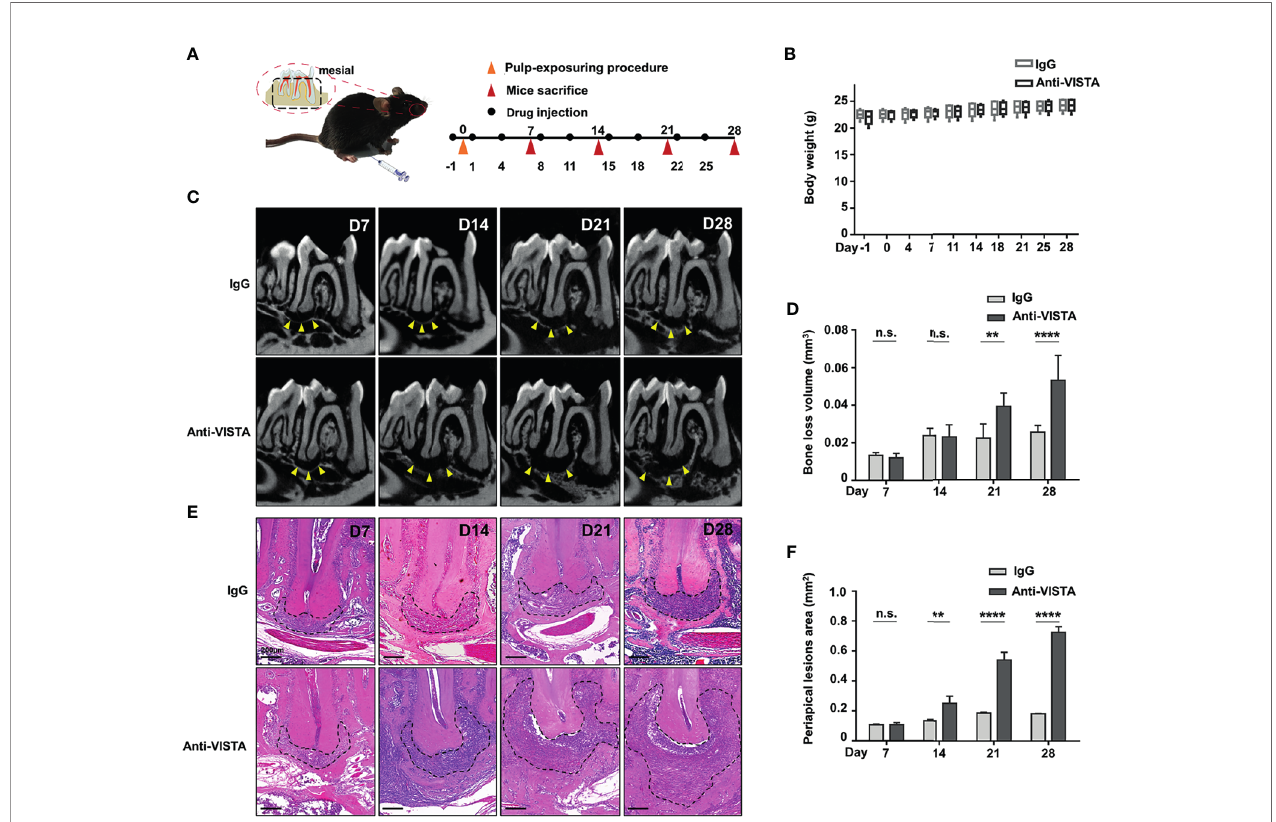
FIGURE 4 | Blockade of VISTA exacerbated bone loss in mouse experimental apical periodontitis. (A) Schematic of experimental design (n=5). (B) Body weight of the anti-VISTA-treated group or IgG-treated group. (C) two-dimensional oriented sections of mouse mandibles at different time points of experimental apical periodontitis. (D) Bone loss volume around the distal root apex of mouse mandibular fi rst molar at different time points. (E) Hematoxylin-eosin staining of apical tissue of mouse mandibular fi rst molars. Scale bars=200 m m. (F) Quantitative analysis of periapical lesions area (indicated by black dash line) in (E) n.s., not signi fi cant. **p < 0.01, ****p <